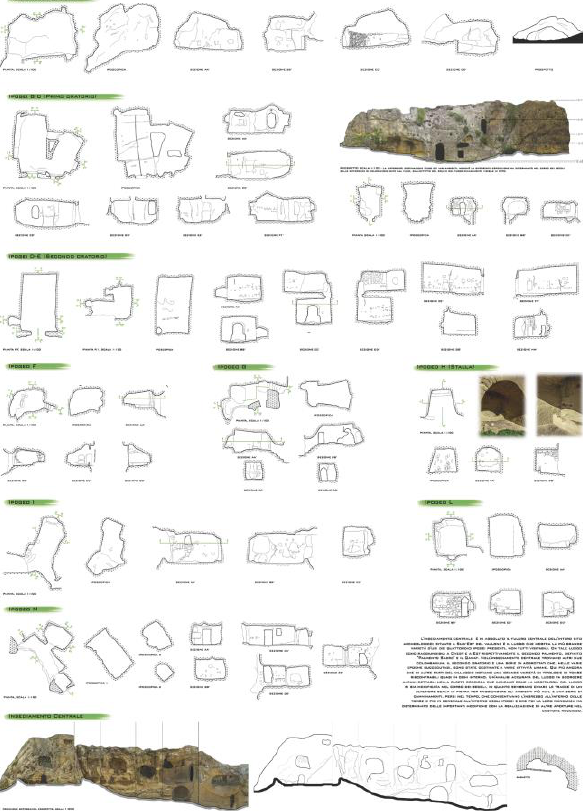
Figure 3. Survey and typological analyses of rock-cut